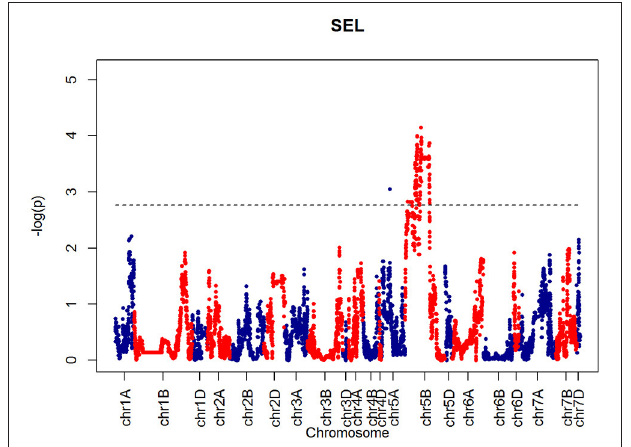
FIGURE 11 | QTLs markers for the trait TIL. Dashed lines indicate threshold (FDR < 0.05, logP4).